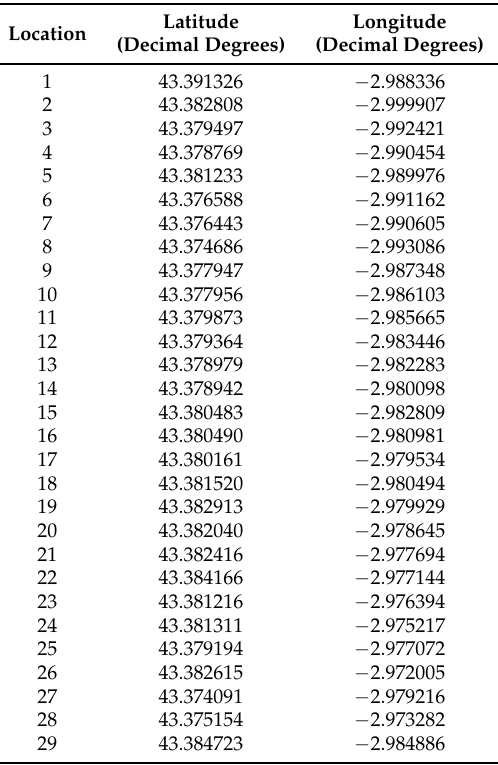
Table A3. Coordinates of the 29